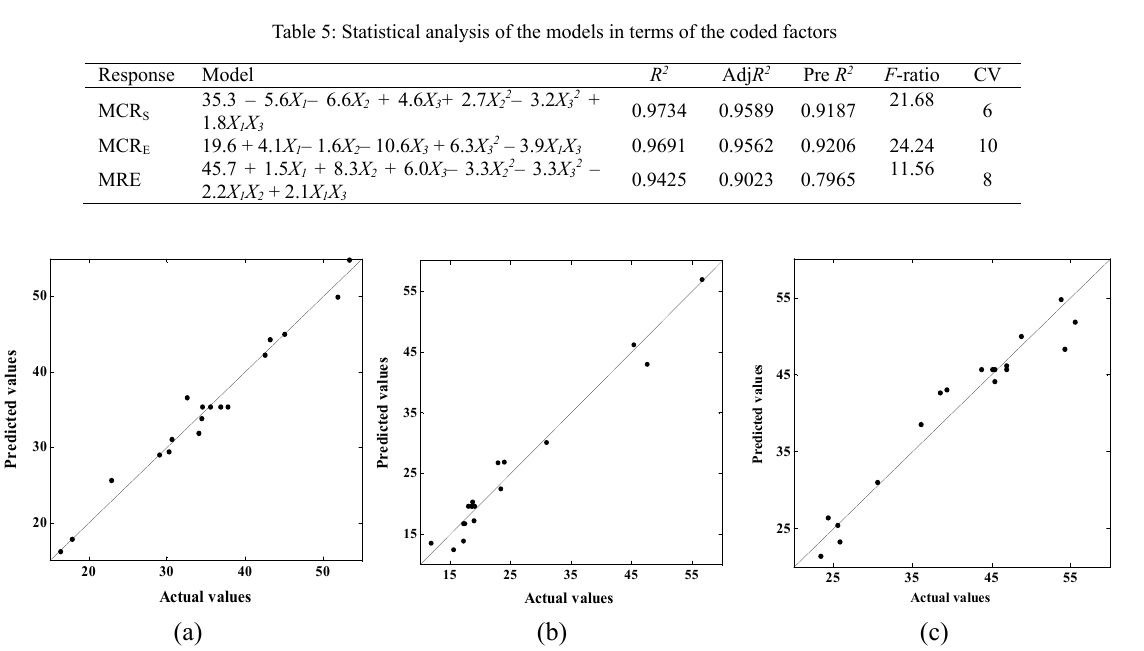
Fig. 1: Observed vs. modeled responses (a) MCR Fig. 1:Observed vs. modeled responses (a) MCR S , (b) MCR E , (c) MRE. Fig. 1:Observed vs. modeled responses (a) MCR S , (b) MCR E , (c) MRE. Fig. 1:Observed vs. modeled responses (a) MCR S , (b) MCR E , (c) MRE.